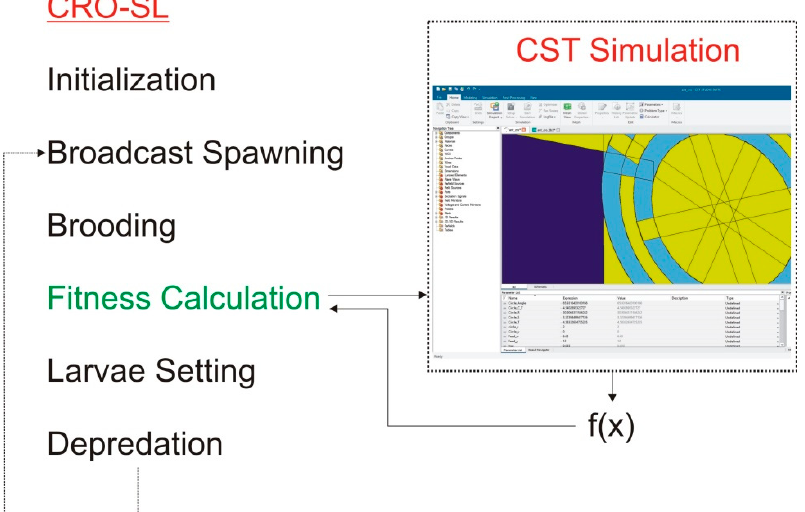
Figure 2. Hybridization of the CST simulation software with the Coral Reefs Optimization with Substrate Layer (CRO-SL) for optimized the parameters of the proposed antenna.